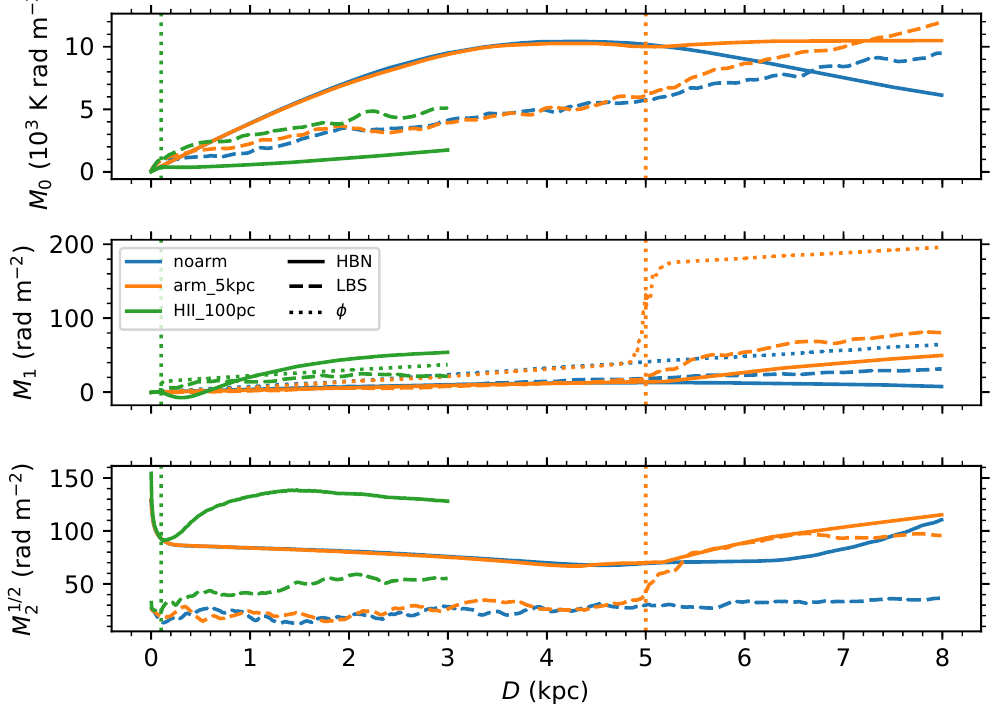
Figure 7. Moments of the Faraday depth spectrum as a function of distance along the sightline. Solid lines show moments of the GMIMS-HBN Faraday spectrum; dashed lines show moments of the GMIMS-LBS Faraday spectrum. The zeroth moment is the polarized intensity integrated across (cid:82) L d φ . The first moment is the intensity-weighted Faraday depth, the Faraday spectrum, M 0 = (cid:82) M 1 = L φ d φ / M 0 ; the dotted lines show the true φ for the input model (from Figure 1), which is in principle the rotation measure one would measure towards a point source at distance D (or a background point source for the maximum value of D ). The second moment is the intensity-weighted (cid:82) L · ( φ − M 1 ) 2 d φ / M 0 ; M 1/2 width of the Faraday depth spectrum, is shown. Dotted vertical lines 2 show the position of the arm in each